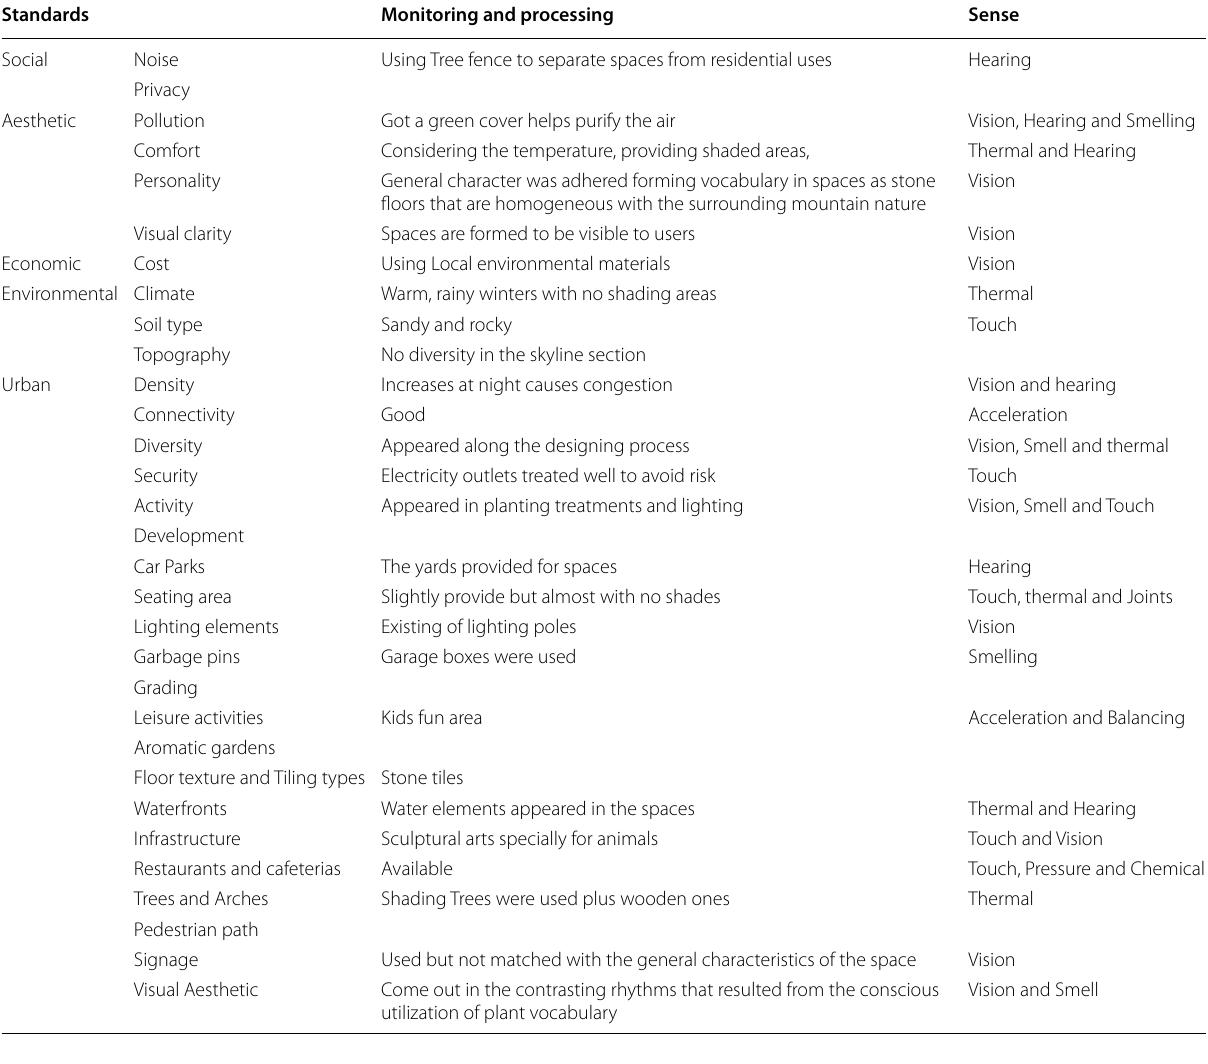
Table 5 Criteria considered when analyzing spaces in Sharm El-Sheikh Standards